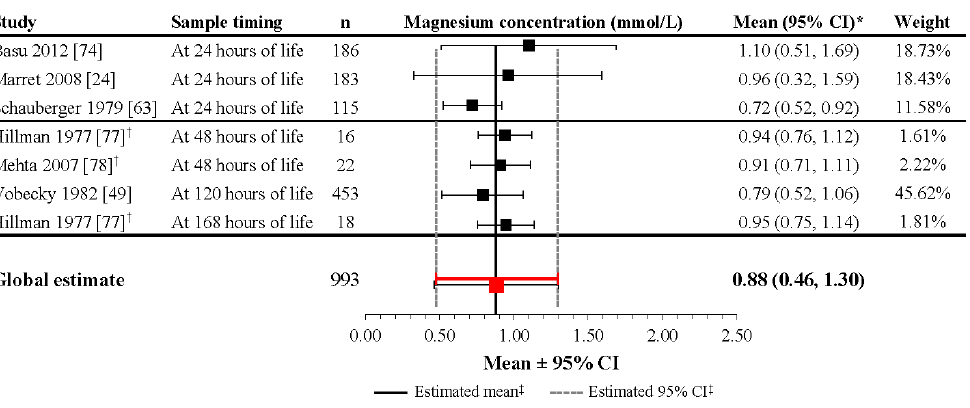
Figure 4. Magnesium concentrations during the first week of life in healthy newborns without magnesium supplementation during pregnancy. * If 95% CIs were not reported in the study, then the 95% CIs were calculated as follows: mean ± (1.96 × SD). † Patient groups within these studies were pooled, as the literature search did not confirm an association between magnesium levels and gestational age, birth weight, or mode of delivery; ‡ Reference line and 95% CI derived using only studies reporting both mean and SD data. Overall statistic for heterogeneity: I 2 = 98.5% ( p < 0.001). CI: confidence interval; n: number of infants; SD: standard deviation.